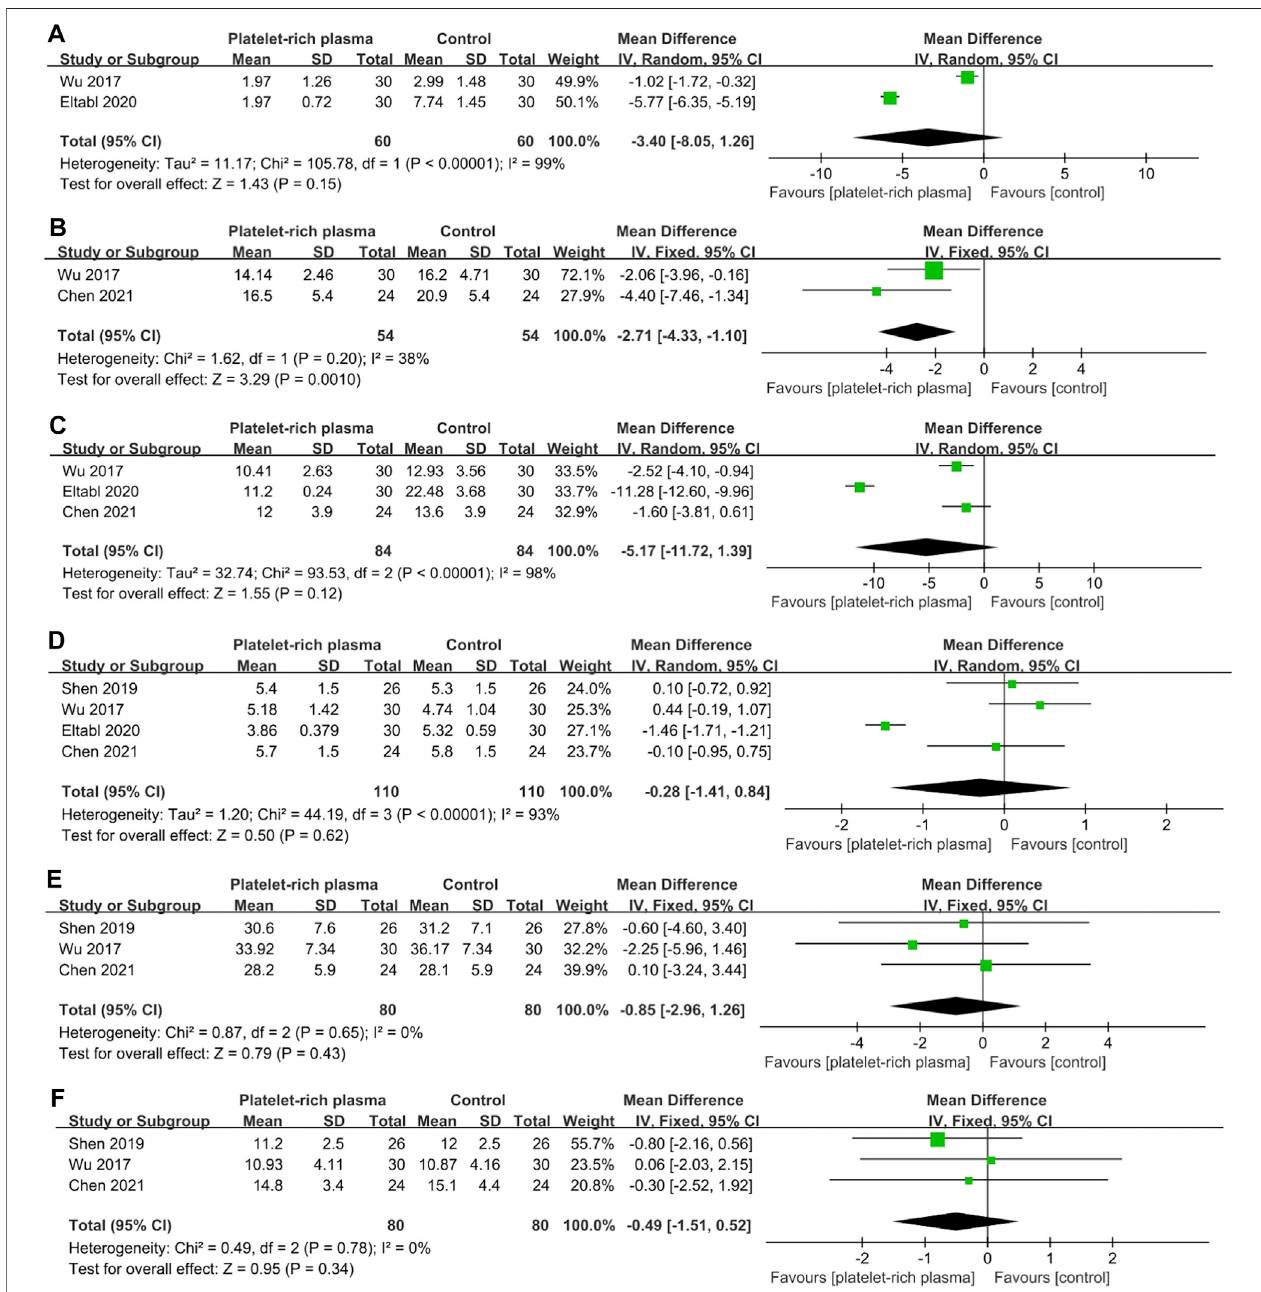
FIGURE 6 | Forest plot showing mid-long-term ef fi cacy of local platelet-rich plasma injection versus other conservative treatments. (A) Visual analogue scale. (B) Symptom severity scale. (C) Functional status scale. (D) Distal motor latency. (E) Sensory nerve conduction velocity. (F) Cross sectional area.